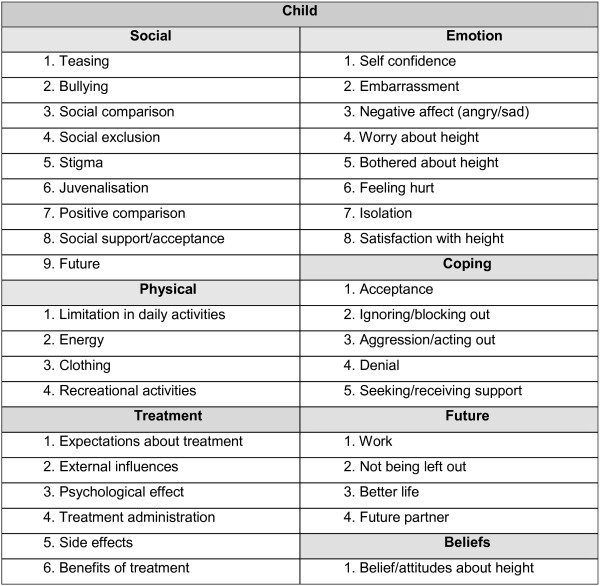
Domains and sub-domains resulting from the focus groups.